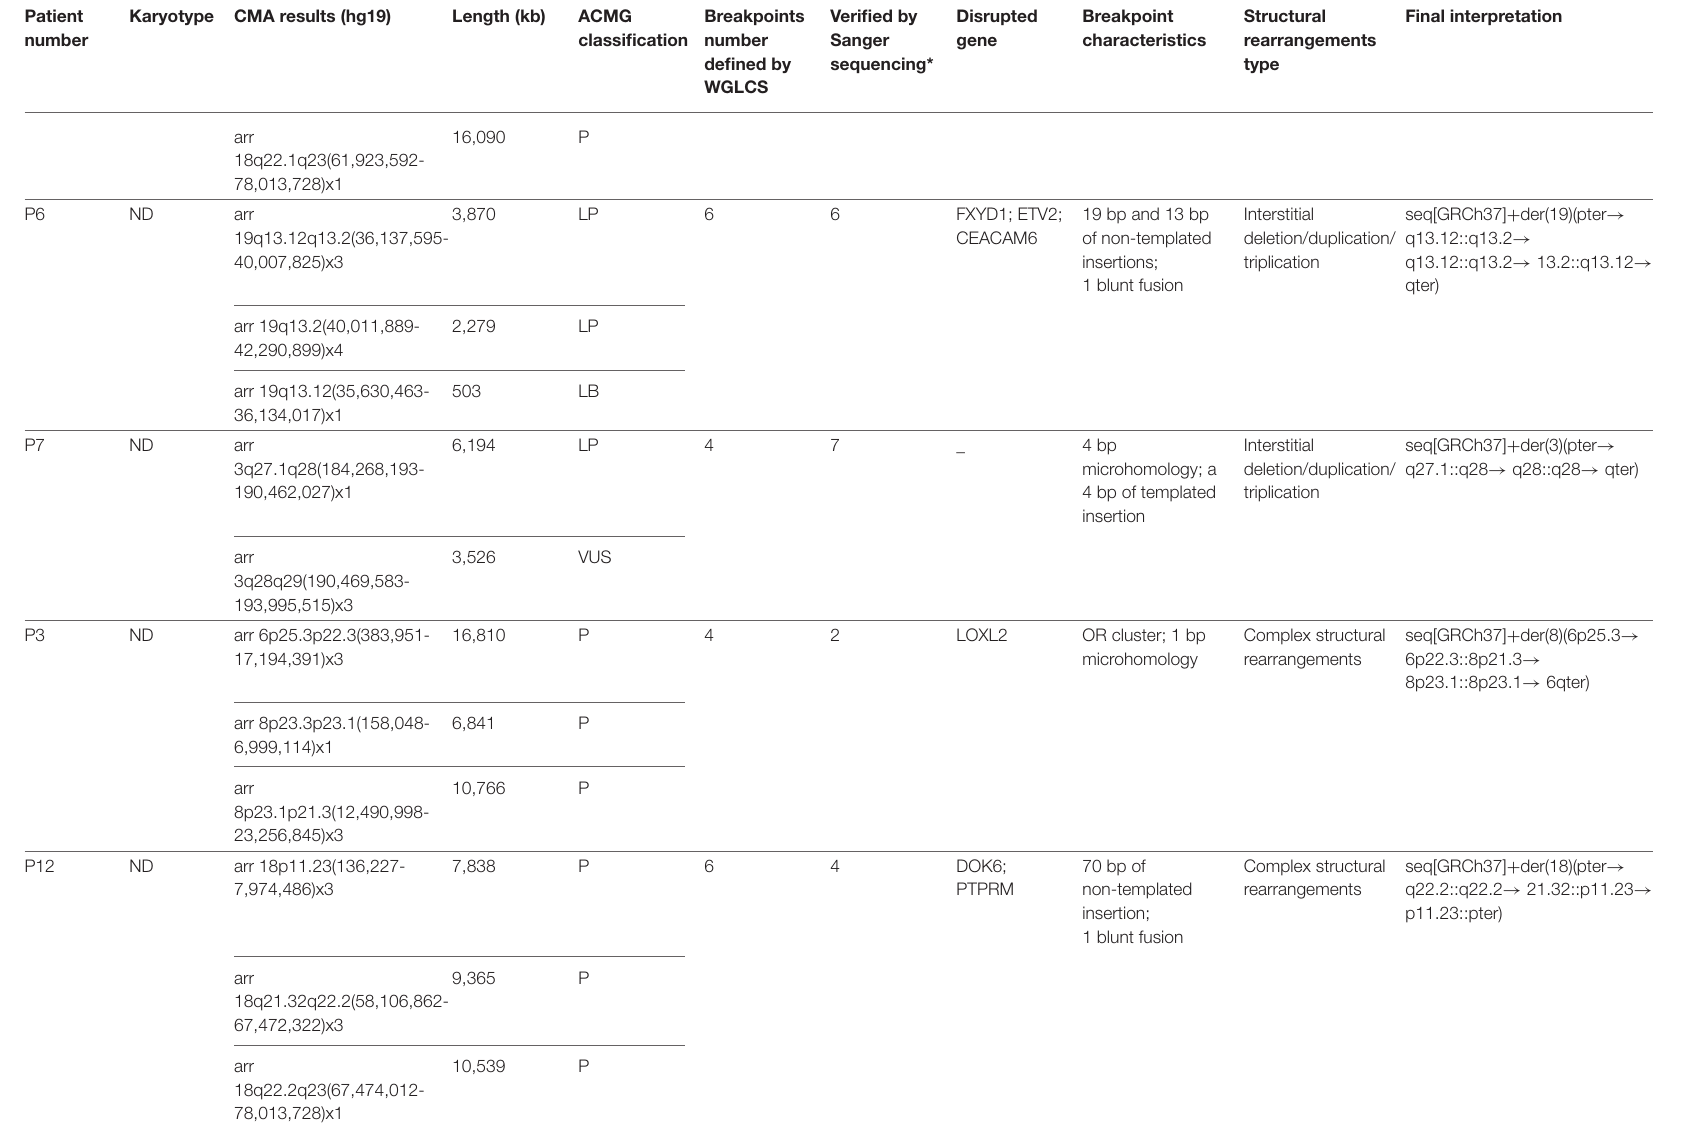
q13.12::q13.2 → 13.2::q13.12 →